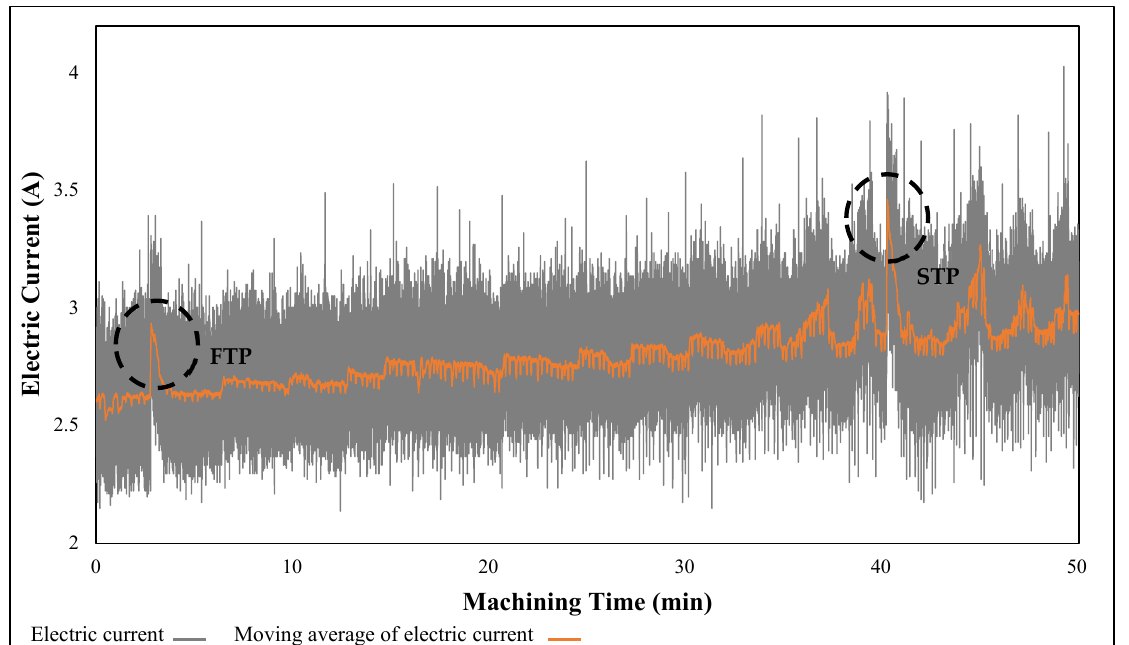
Figure 7. Electric current signal related to the spindle as a function of machining time.